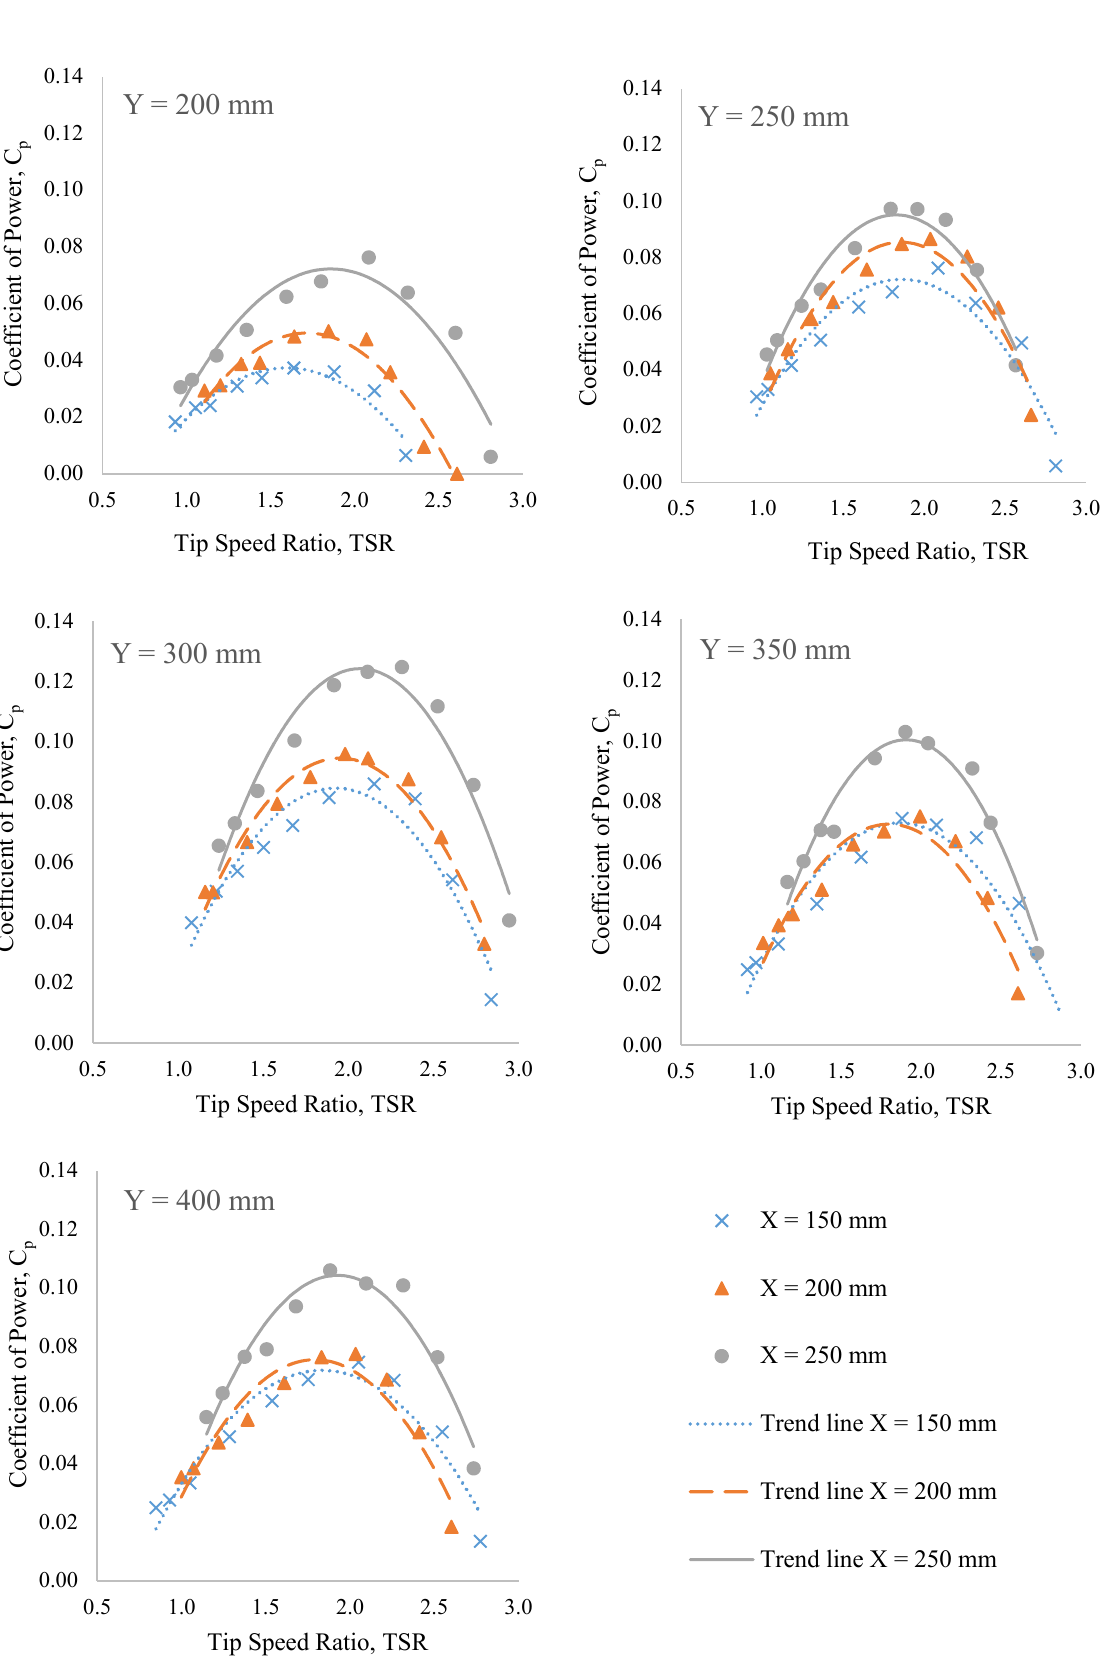
Figure 10. Coefficient of power against tip speed ratio for X = 150 mm, 200 mm, and 250 mm at all vertical wind turbine